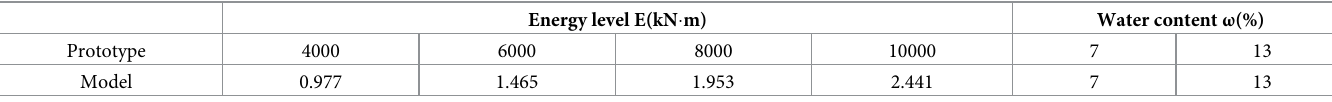
Table 2. Comparison of the prototype model parameters.